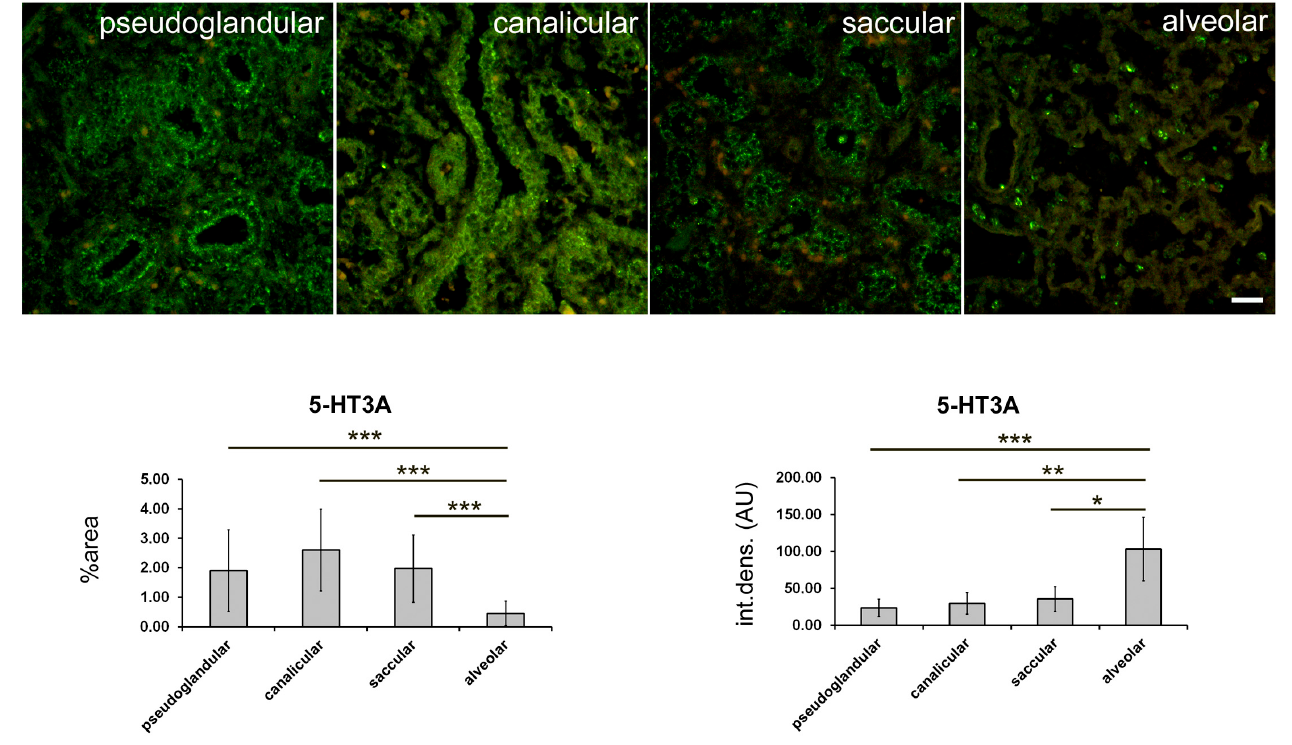
Figure 7. Quantification of 5-HT3A expression at different stages of fetal lung development. Immunofluorescence staining with 5-HT1A antibodies was performed. Representative images for different stages of lung development are shown. Green fluorescent staining—positive 5-HT3A receptor expression. Images were acquired at 400× magnification. Scale bar = 50 µm. Percentage of a sectional area with positive signal (% area) and integrated density (int. dens.; arbitrary fluorescence units—AU) were measured and are shown in graphs. * p < 0.05; ** p < 0.01; *** p < 0.001 between the indicated developmental stages (bars).